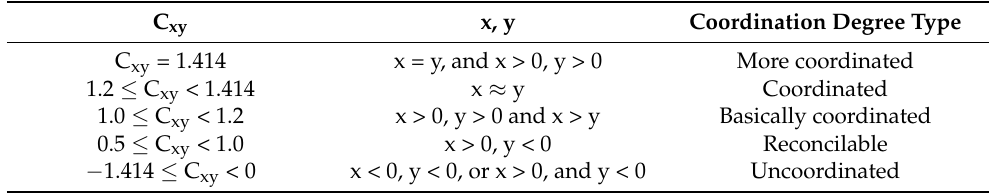
Table 2. Definition of coordination